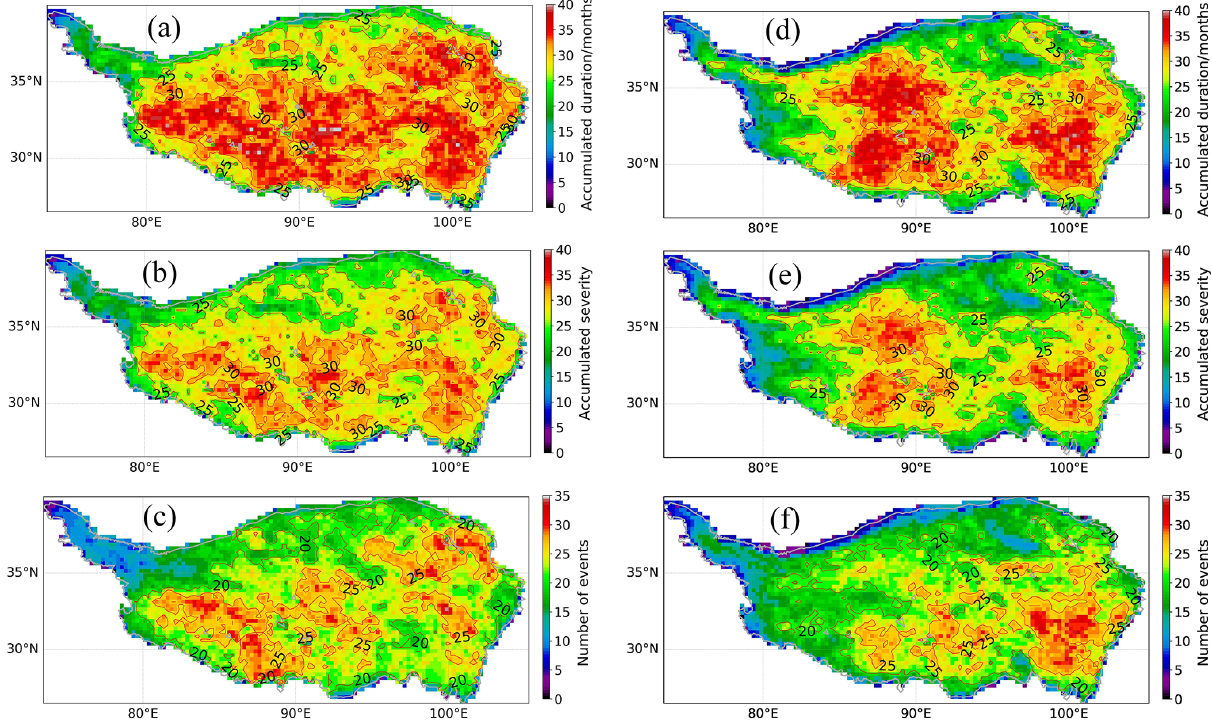
Figure 6. Spatial distribution of the accumulated drought duration (a,d) , severity (b,e) , and number of events (c,f) for the identified soil moisture drought events in summer (May–September) over 1961–2014 in a joint space–time perspective based on GLDAS and ERA5 soil